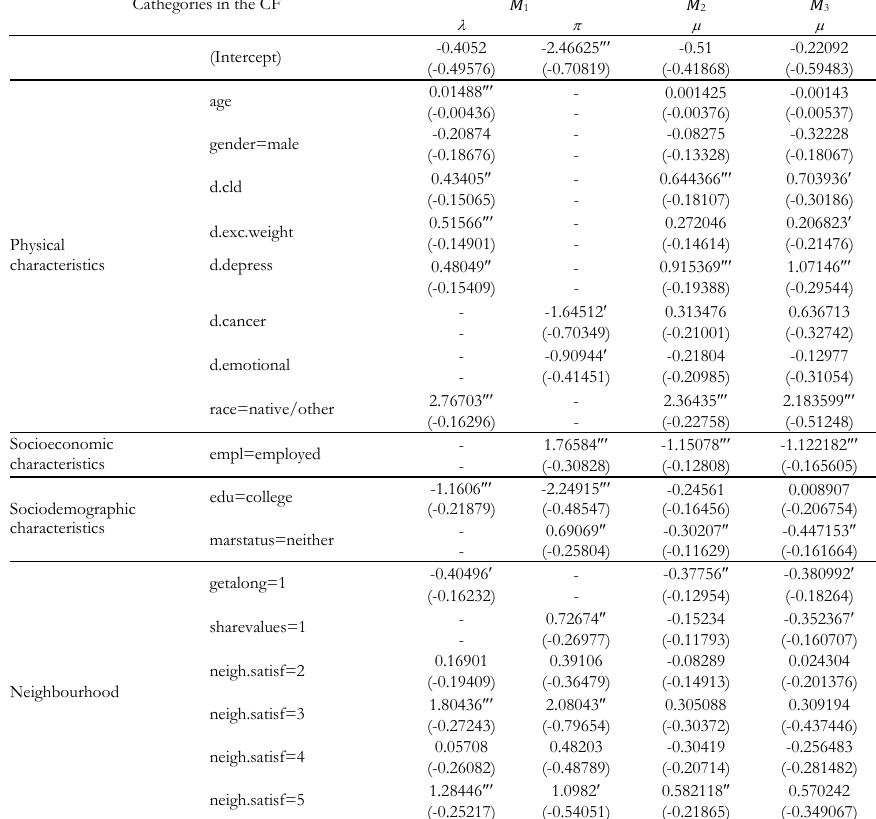
Estimated coefficients (and their standard erros in parenthesis) for the linear components of the linear predictors of the Models  1 (ZIP),  2 (Poisson),  3 (Negative Binomial) (  denotes significance at 0.05,  at 0.01,  at